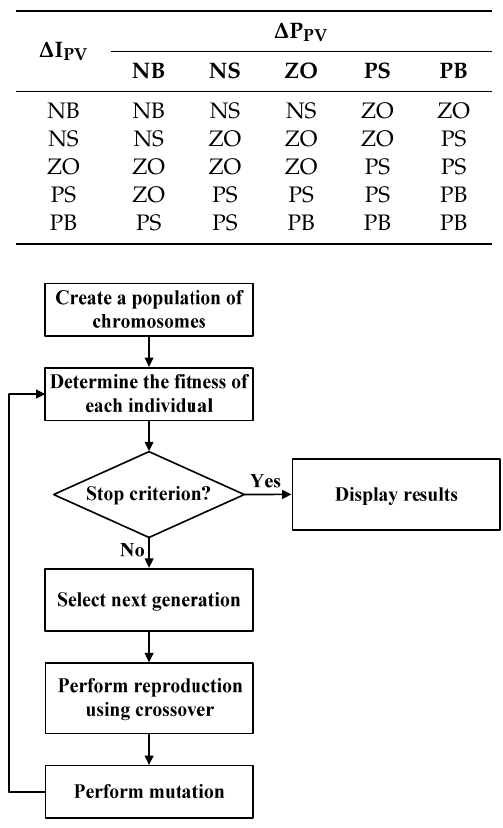
Table 3. Rule-based lookup table based on the fuzzy logic.